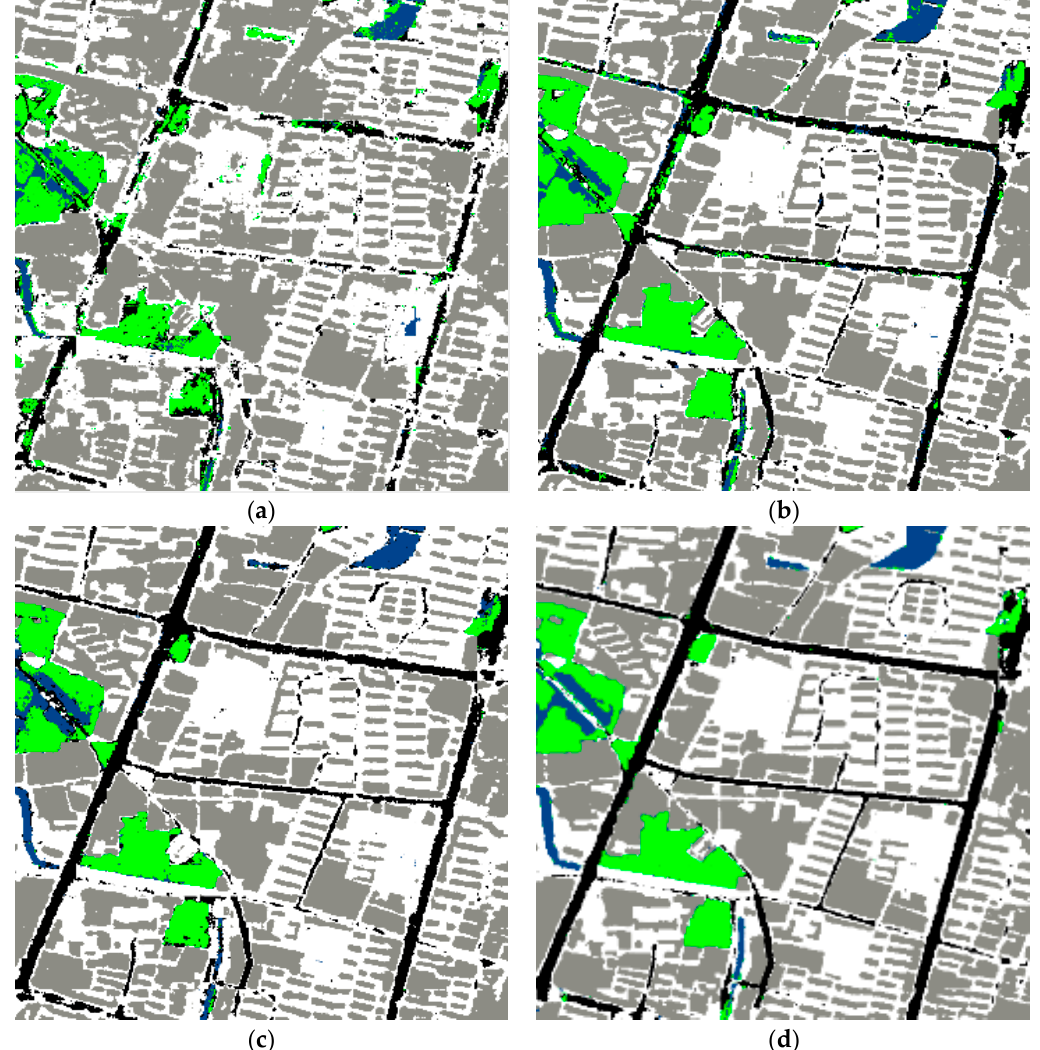
Figure 5. Classification results by different models on testing image data: ( a ) DeepLabv3; ( b ) FC fusion path; ( c ) A-ASPP; ( d ) our network.